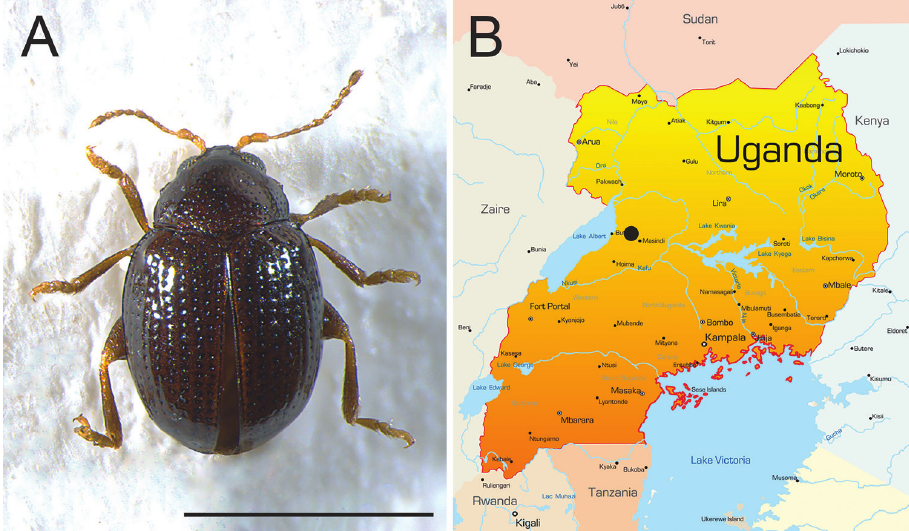
Figure 1. Ugandaltica wagneri sp. n. A Habitus of male holotype in dorsal view B Collecting site (black dot). Scale bar: 1